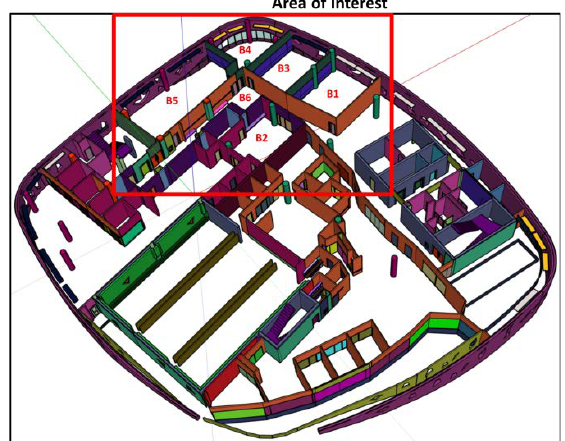
Figure 5. Area of interest in the Bergeron Centre for the experiments. Panoramic images were captured in rooms B1, B2, B3, B4, B5, and B6. The RGB images were stitched together to generate a single 360 degree panoramic image, this was accomplished in real-time using OpenCV’s implementation of (Brown and Lowe, 2007). Figure 6 shows the input panoramic images and corresponding synthetic panoramic images. Vertical Line Features extracted from synthetic panoramic images and input panoramic image are shown with green lines and red lines, respectively. Results from using the approach of (Gavrilla and Groen, 1992) shown in Table 2, revealed that using the corner points of Vertical Line Features in geometric hashing’s conventional voting strategy produced many false candidates in the recognition phase because the required search area was large. Further correct matches could not be reliably identified. Table 3 reveals that matching panoramic and synthetic panoramic images using the proposed approach produced more true positives (i.e., accepted correct matches) than false positives (i.e., accepted incorrect matches), and more true negatives (rejected incorrect matches) than false negatives (i.e., rejected correct matches). Candidate matches were selected if their NCC value was higher than 0.8, and their NCC was the highest in its row and column. The results indicate that there are outlier matches in the list of candidate image-to-model line matches. However, when a panoramic image was considered to match the synthetic panoramic image that produced the largest number of candidate image-to-model line matches, the match was always correct in this dataset.